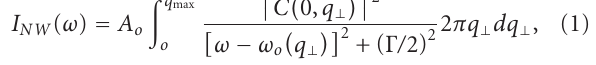
scattering process. In fact, bulk phonons of wavevector up to q ∼ 1 /D ( D is diameter of the nanowire) contribute to the first-order Raman